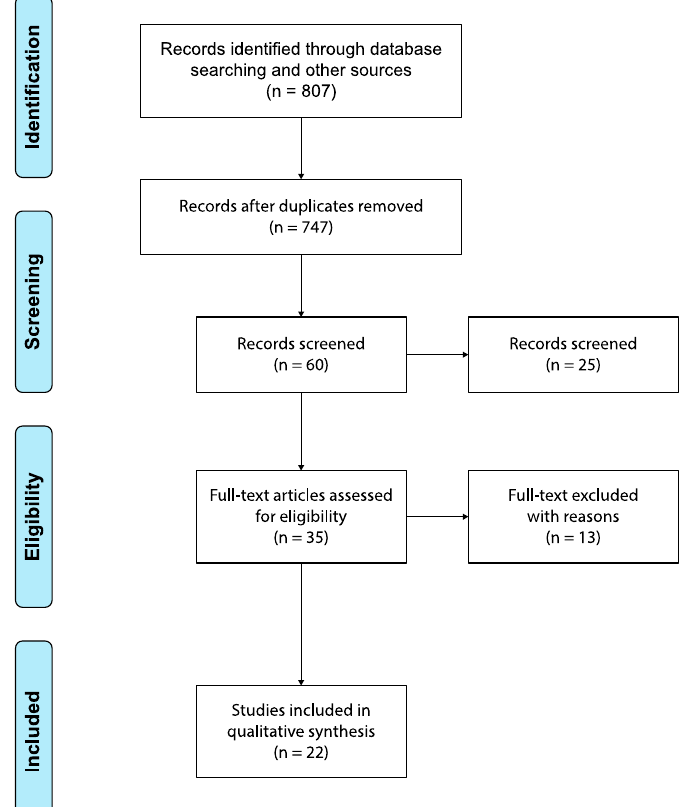
Figure 1. Flow diagram according to PRISMA. Table 1. Demographic data of collected studies with various therapeutic methods.